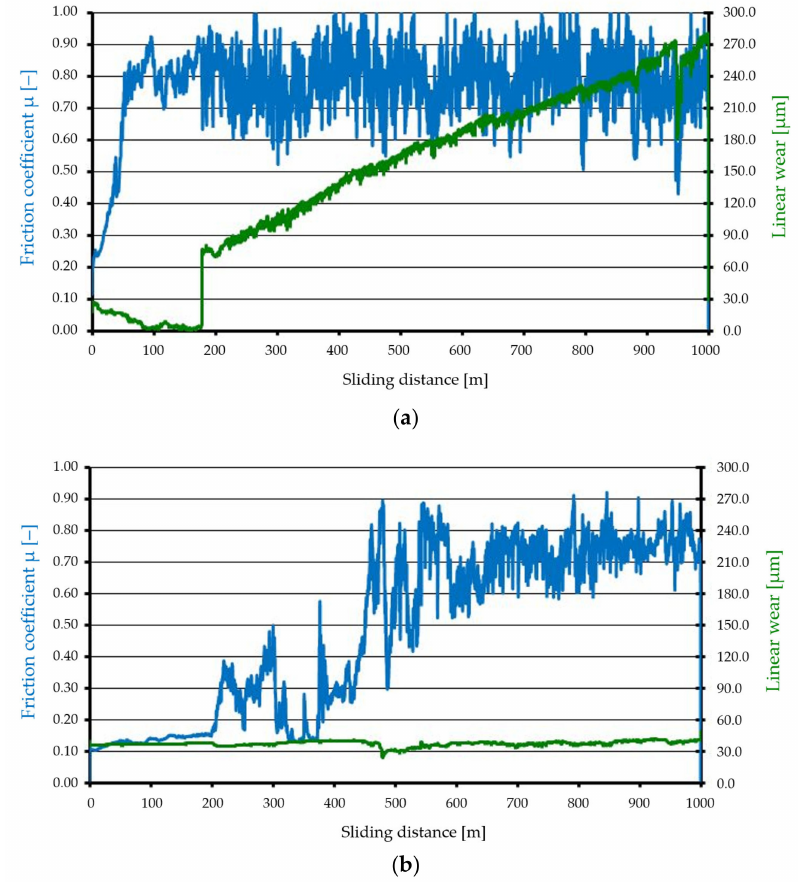
Figure 5. Tribological characteristics (studies without lubricant): ( a ) Surface A, ( b ) Surface